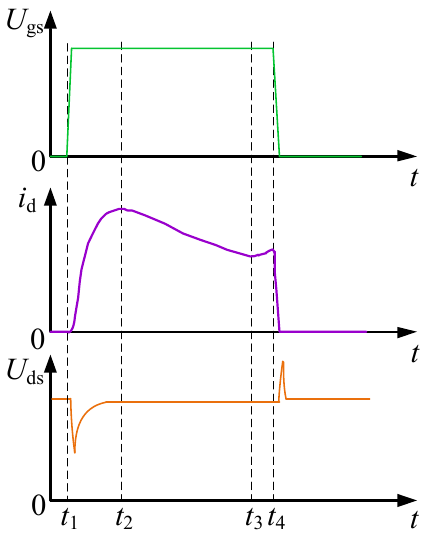
Figure 3. Short-circuit waveforms of SiC MOSFET for hard-switching fault